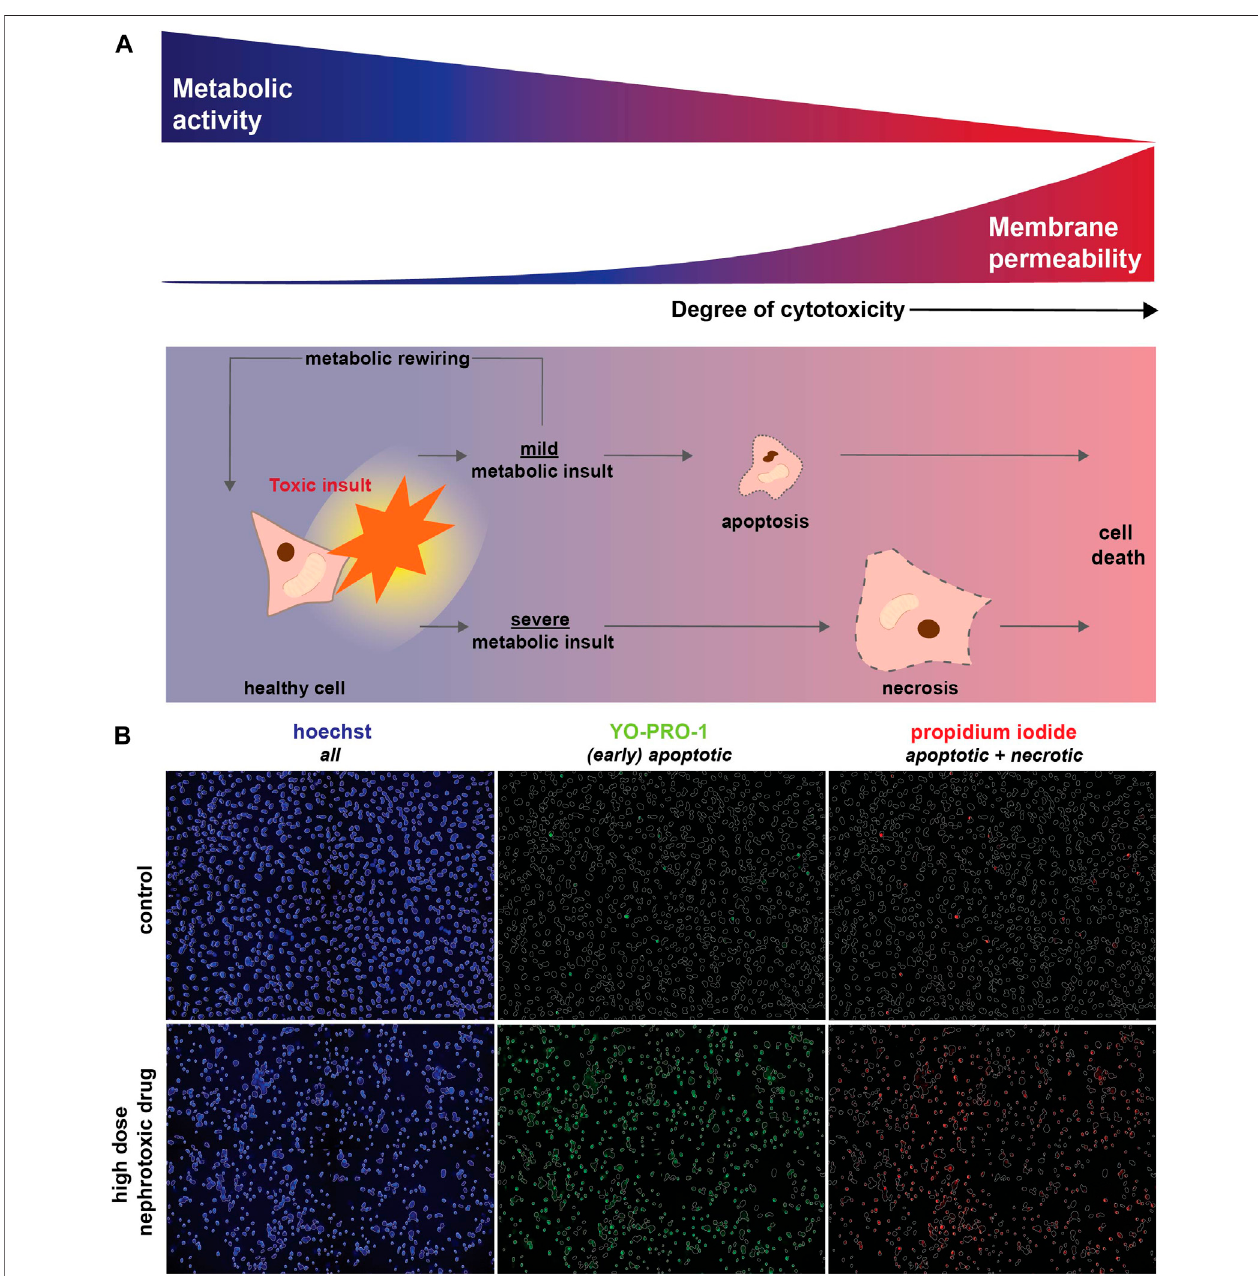
FIGURE 1 | Toxic(metabolic) insultsinterferewithcellularmetabolicactivityand eventuallyresultincelldeath. (A) Uponatoxicinsult,cellularmetabolism could be only mildly reduced leading to the induction of apoptosis. Alternatively, cellular viability might be restored via metabolic rewiring ( i.e. , the capacity of cells to switch to alternative metabolic pathways upon changing conditions, including nutrient availability or drug exposure). However, when a toxic insult severely inhibits metabolic function it triggers necrosis,whichresultsinlossofmembraneintegrityandultimatelycelldeath.AsMTTmeasurescellularmetabolicactivity,thismethodwillalsodetectchangesincase of a mild toxic insult, which may eventually not affect cellviability (blue). Incontrast,a fl uorescent-based celldeath detection approachbased on membrane permeability will onlyberelevant ifapoptoticornecroticmechanisms havebeenactivated(red). (B) Fluorescent-basedanalysisofcelldeath combines hoechst(blue)tovisualize allcellswith Yo-Pro-1-iodide(green)thatcrossesplasmamembranesof(early)apoptoticcellsinparticularandpropidiumiodide(red)thatstainsnecroticcells.Celldeath,detectedasYo- Pro-1-iodide and propidium iodide positive cells, is induced by a high concentration of a nephrotoxic drug (cisplatin, 100 μ M) compared to a vehicle control.